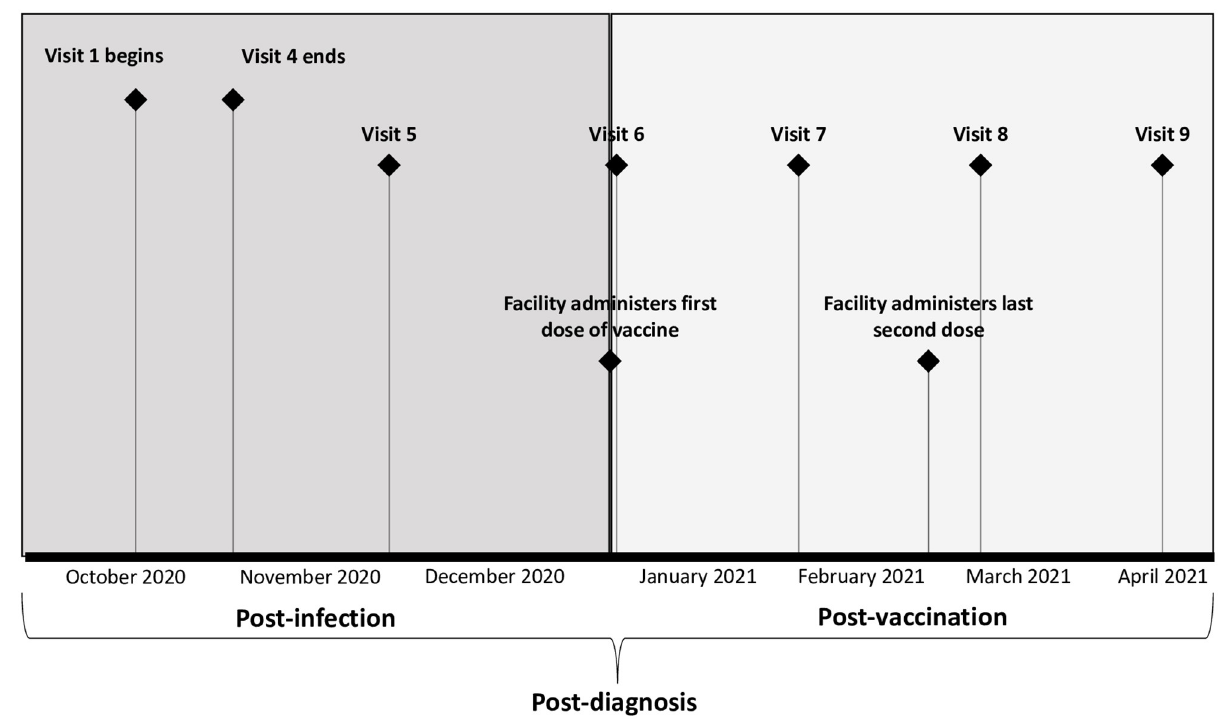
Fig 1. Timeline of participant visits and evaluation activities conducted, by time period—Georgia, October 2020–April 2021. Upon enrollment after a SARS-CoV-2–positive diagnosis by BinaxNOW ™ COVID-19 Ag Cards and/or real-time reverse transcription polymerase chain reaction, the first four visits were conducted every other day. Visits 5–9 occurred monthly. The post-diagnosis period was defined as the time after each participant’s first positive SARS-CoV-2 test result. The post-infection period was defined as the time from SARS-CoV-2 diagnosis to receipt of first Pfizer-BioNTech COVID-19 Vaccine dose. The post-vaccination period was defined as the time after receipt of first vaccine dose to the end of the evaluation period. Nine participants received their two vaccine doses 21 days apart; one participant received their two vaccine doses 28 days apart.